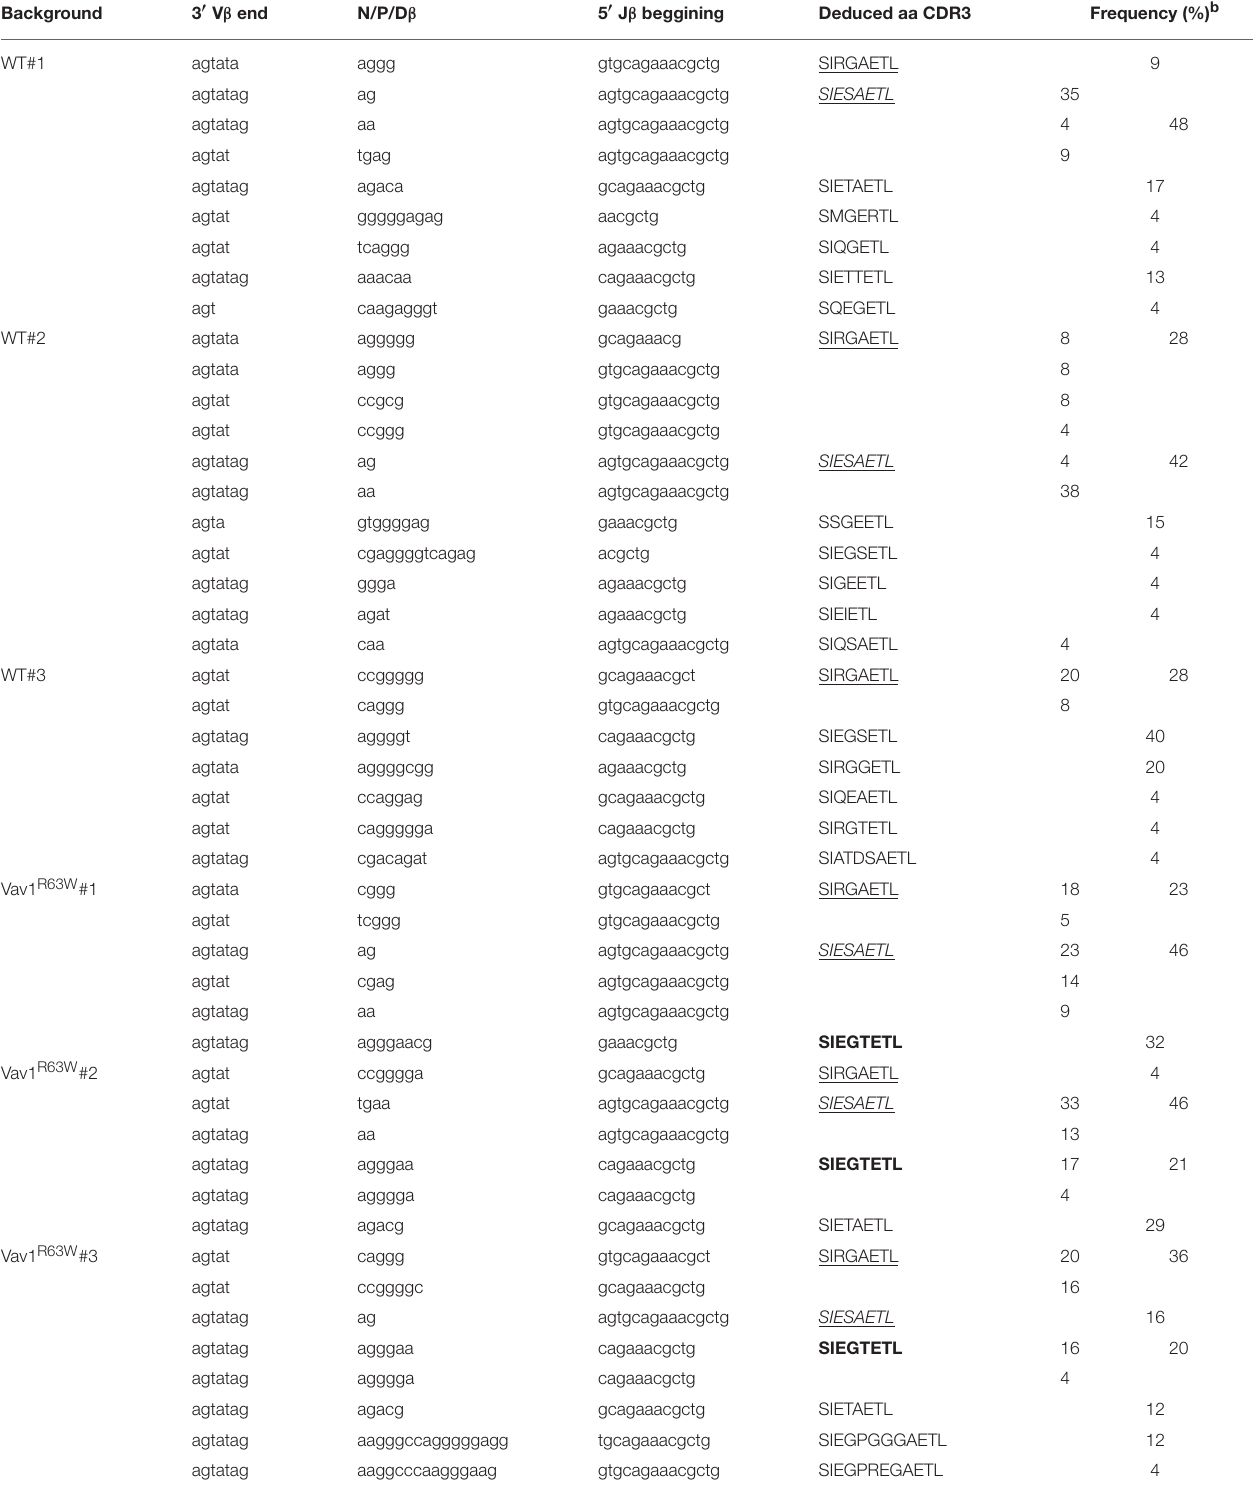
TABLE 1 | CDR3 β sequences of α 146-162 AchR specific CD4 + T cells (V β 6-J β 2.3 rearrangement) a .